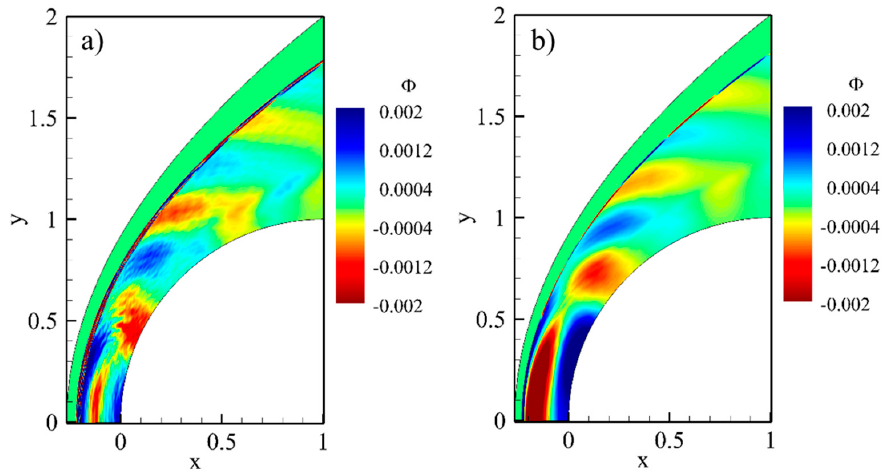
Figure 24. Experimental DMD modes: ( a ) Dryer mechanism at 408.3 kHz; and ( b ) UCSD mechanism at 419.2 kHz.